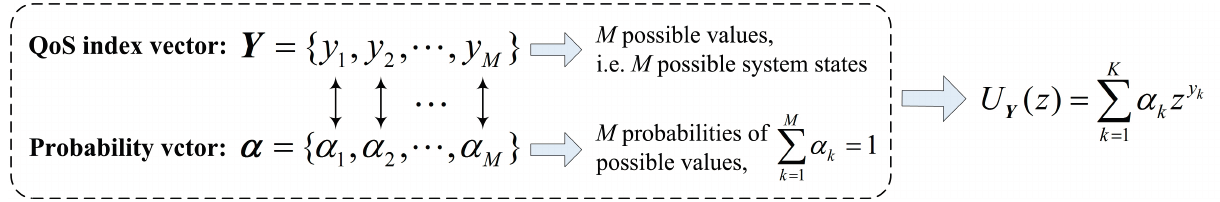
Figure 4. Relationships between Y and α in the